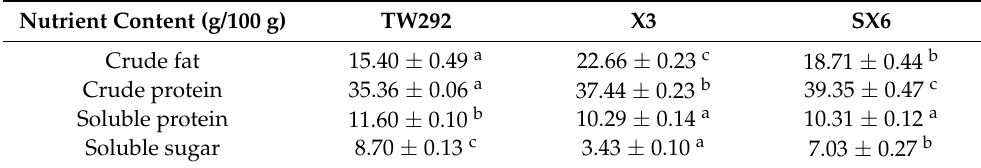
Table 1. Chemical compositions of three vegetable soybean